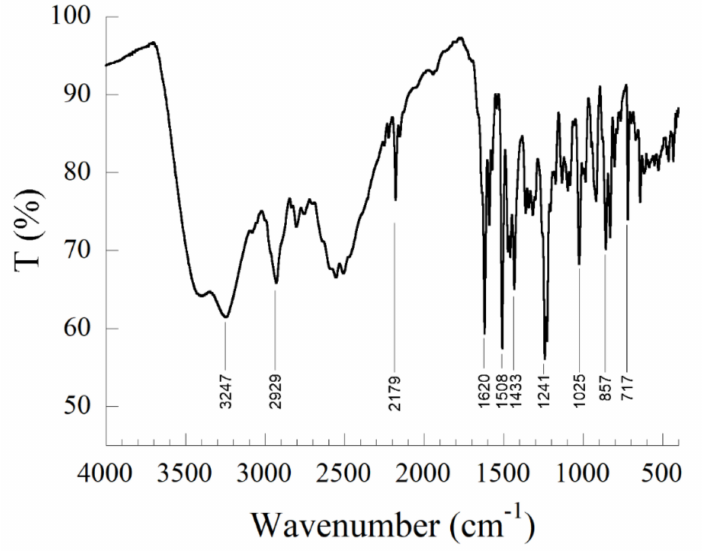
Figure 6. FTIR spectrum of